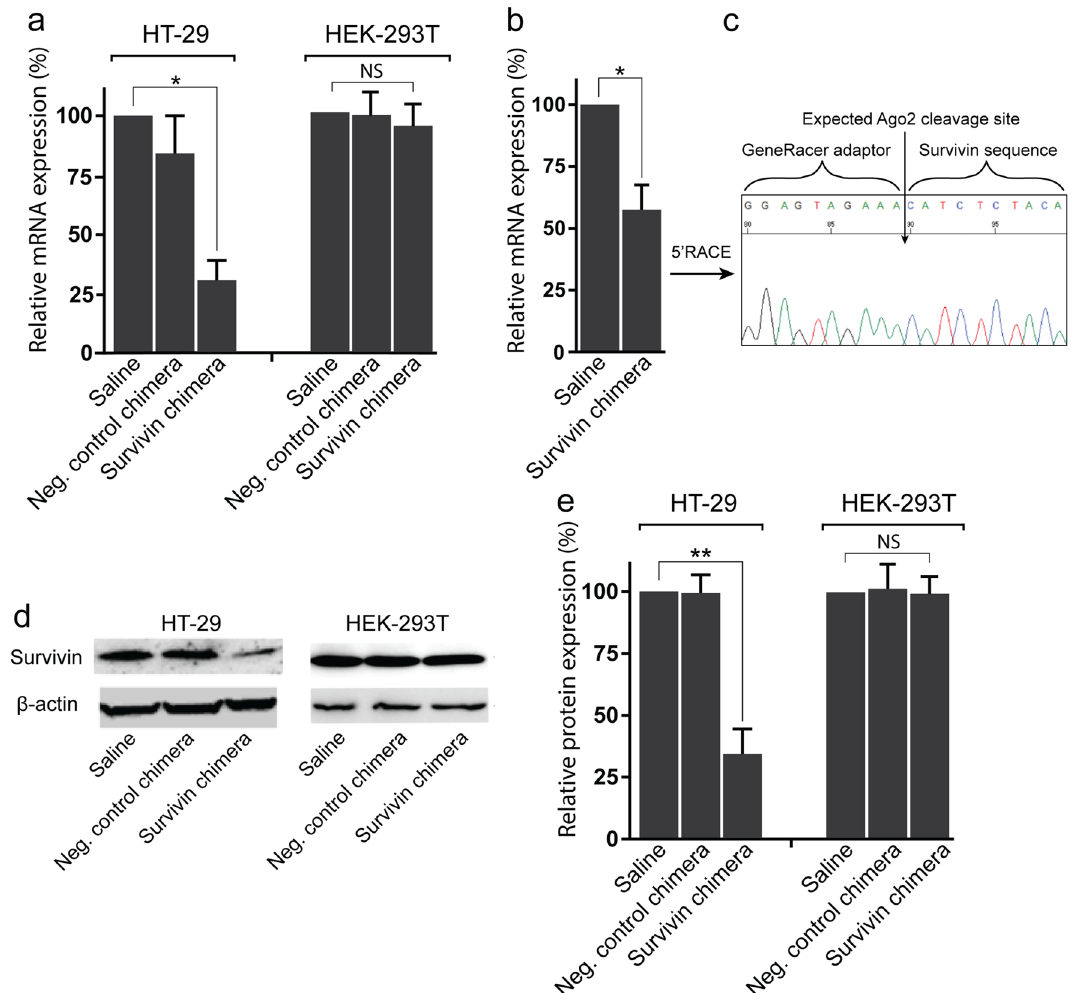
Figure 1. EpCAM aptamer-guided RNAi effectively silenced survivin. ( a ) Specificity and efficacy of EpCAMaptamer guided RNAi in knocking down survivin mRNA. Chimera or negative control chimera were incubated with HT-29 or HEK-2913T cells for 24 hours and the total RNA was extracted for qRT-PCR analysis of survivin mRNA levels. GAPDH was used as an internal control. ( b , c ) HT-29 Tumour-bearing mice were treated with 2 nmol/mouse of PEG-labelled chimera for 48 hours. The tumours were collected for RNA extraction followed by qRT-PCR analysis of survivin mRNA expression ( b ) and 5 ′ RACE assay ( c ). ( d ) Effective downregulation of survivin protein via EpCAM aptamer-guided RNAi. Chimera or negative control chimera were incubated with HT-29 or HEK-2913T cells for 48 hours and the survivin protein levels were analyzed using Western blot analysis. β-actin was used as a loading control. ( e ) The bar graph shows the survivin protein levels in various treatment groups. Data shown are means ± SEM, n = 3. * p < 0.05, ** p < 0.005. NS, no statistically significant